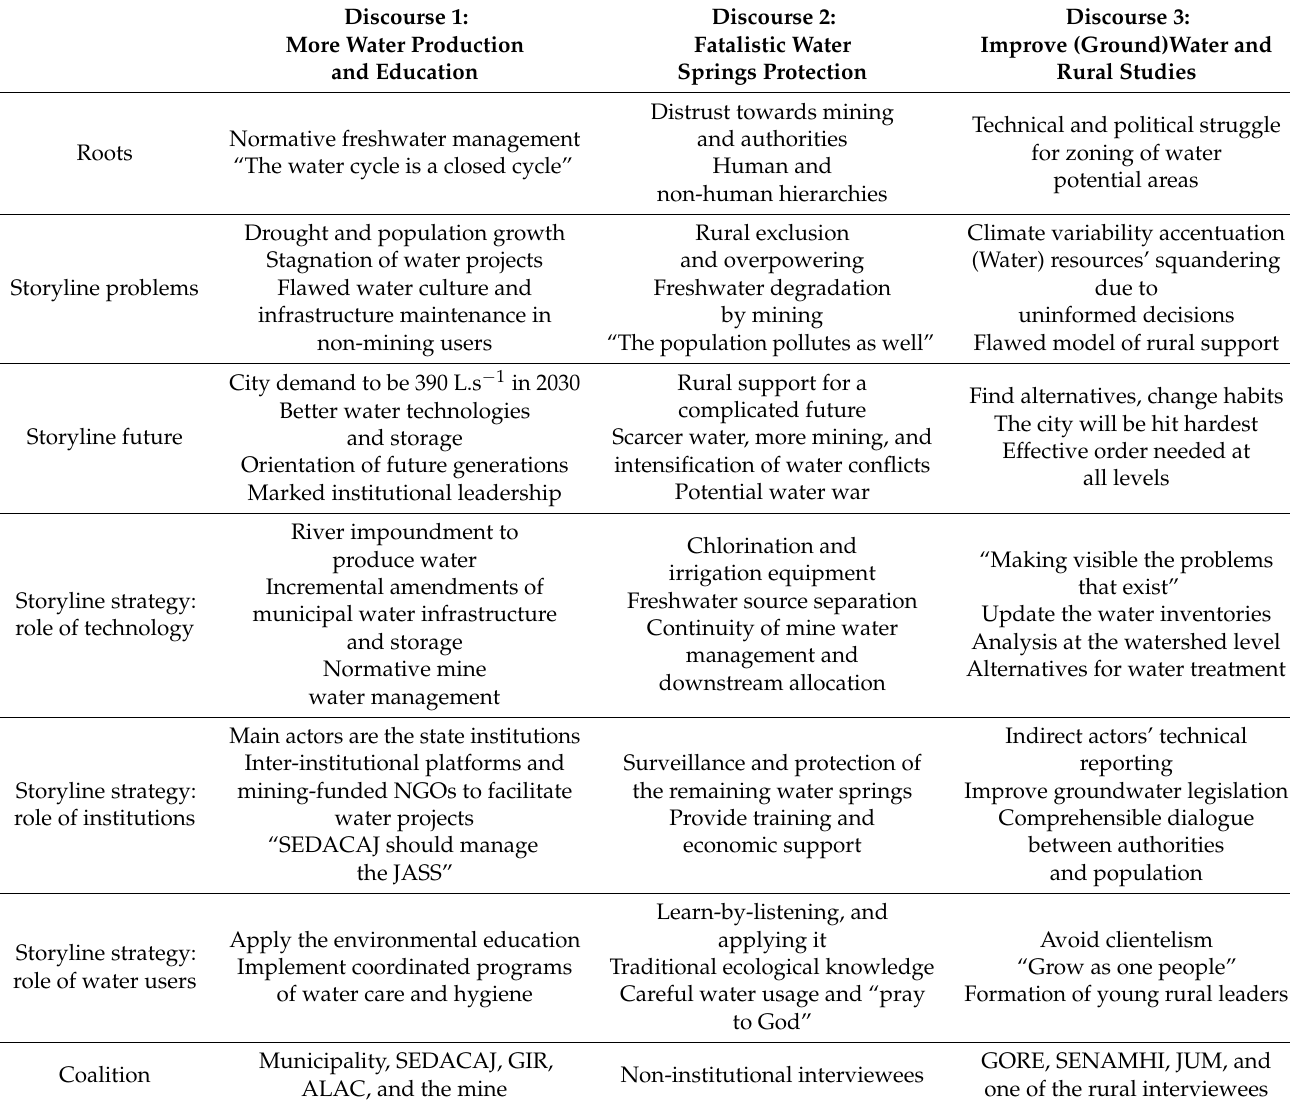
Table 2. Summary of the three